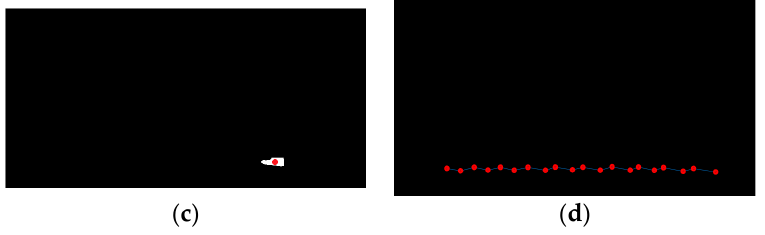
Figure 3. ( a ) Segmented feet silhouettes between two initial contacts; ( b ) AFI obtained by averaging the feet silhouettes; ( c ) position of the foot flat obtained by applying a threshold; ( d ) centroids of foot flat obtained for the entire video sequence.